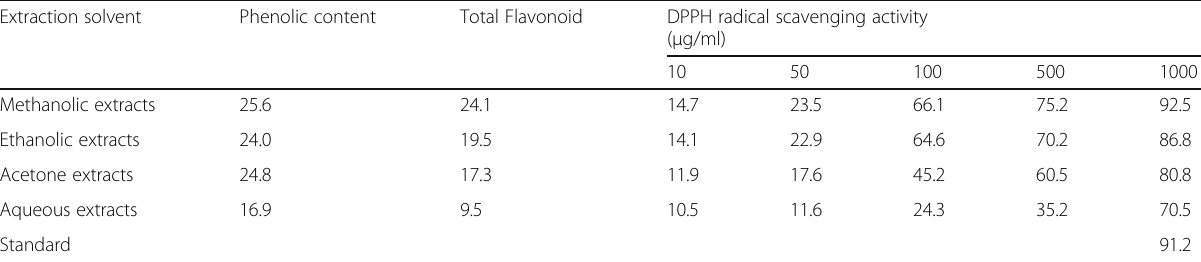
Table 2 Phenolic content, Flavonoid content and DPPH radical scavenging activity of Olea europaea L. leaf extracts along with